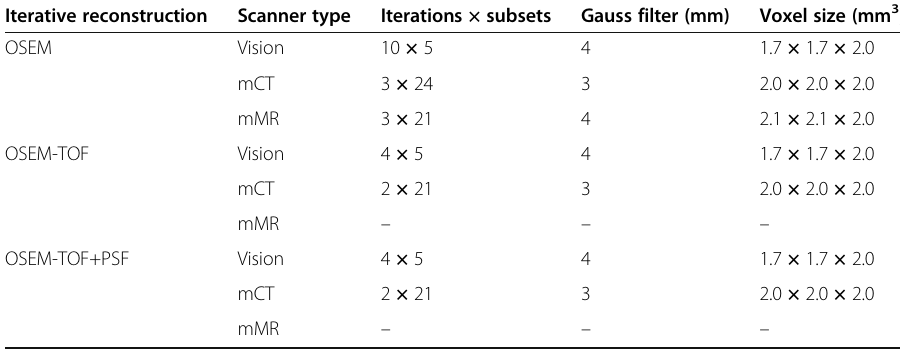
Table 1 Standard clinical reconstruction parameters for the different PET scanners Iterative